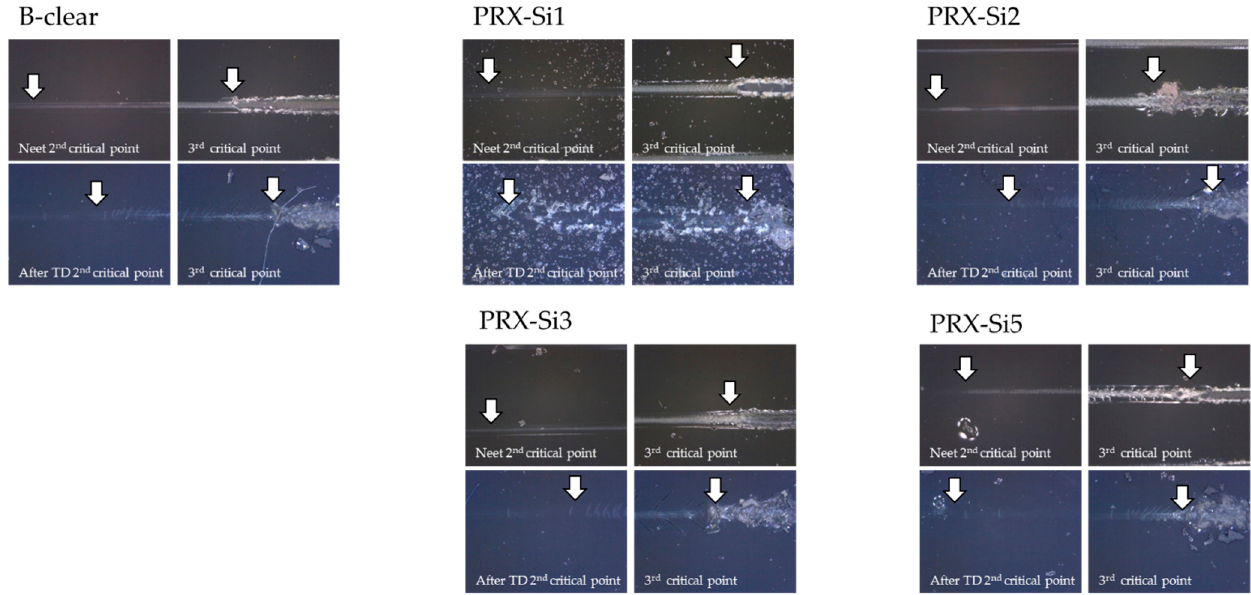
Figure 9. Variation and observation of scratch damage mechanisms around 2 nd and 3 rd critical loads under thermal degradation conditions.